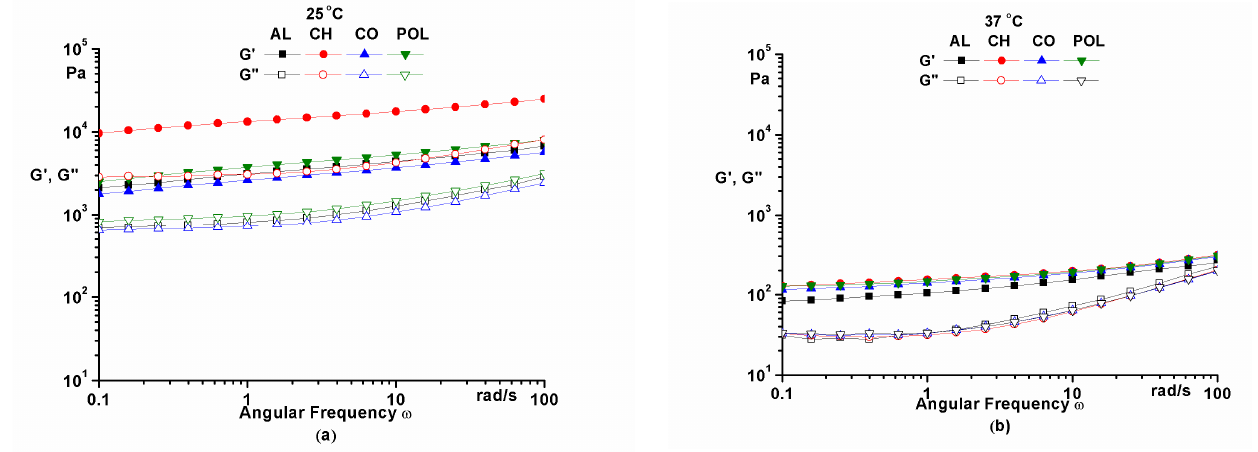
Figure 2. Frequency sweep at 25 °C ( a ) and 37 °C ( b ). Temperature test was performed at a constant frequency ( ω = 10 rad/s) and a constant amplitude in the linear viscoelastic range ( γ = 0.01%) with a temperature variation in the range 20–40 ◦ C (Figure 3).